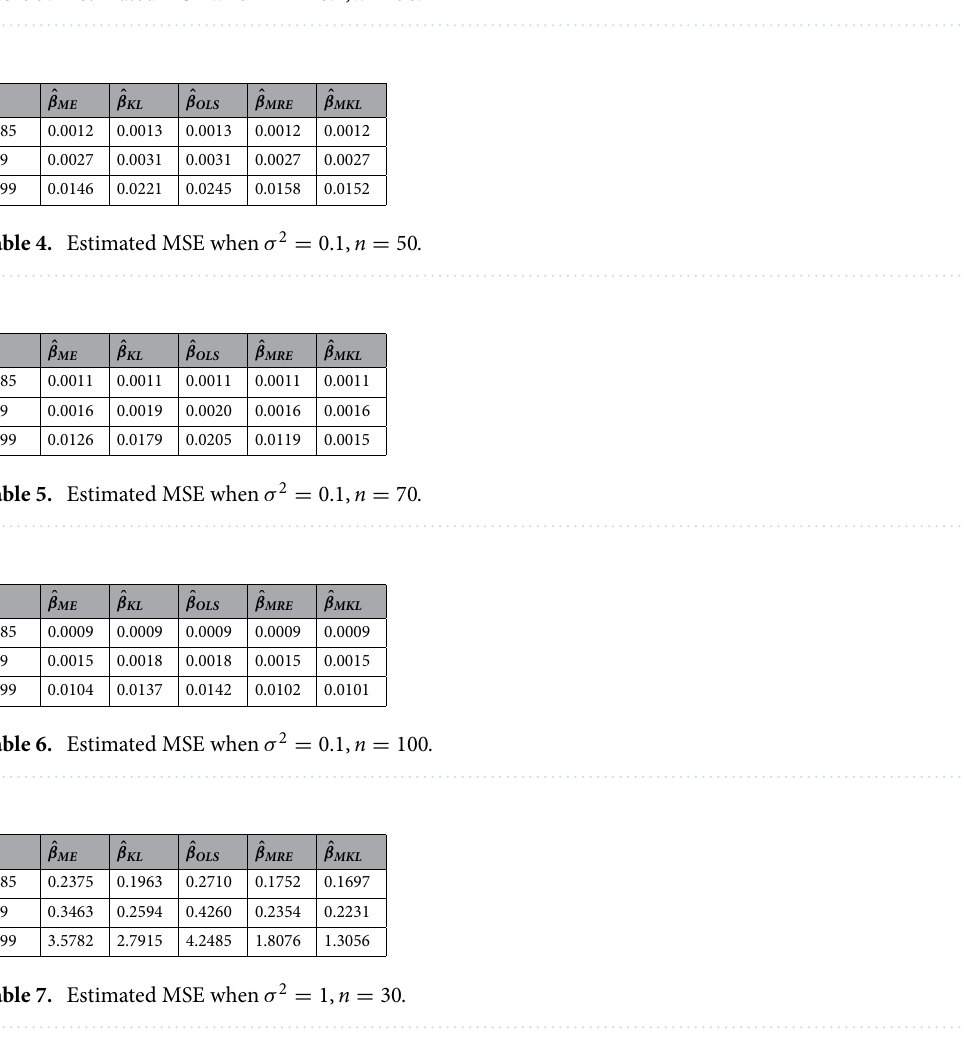
Table 3. Estimated MSE when σ